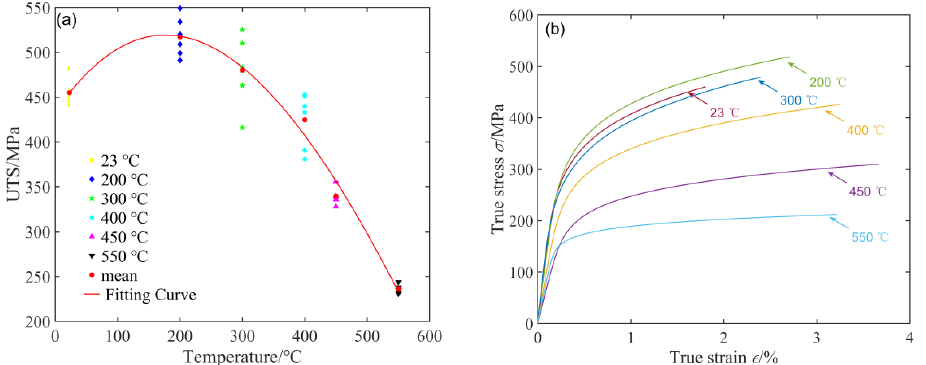
Figure 2. Tensile properties of compacted graphite cast iron (CGI) at 23~550 °C. ( a ) UTS of CGI as a function of temperature, ( b ) true stress–strain curves of CGI at 23~550 °C.